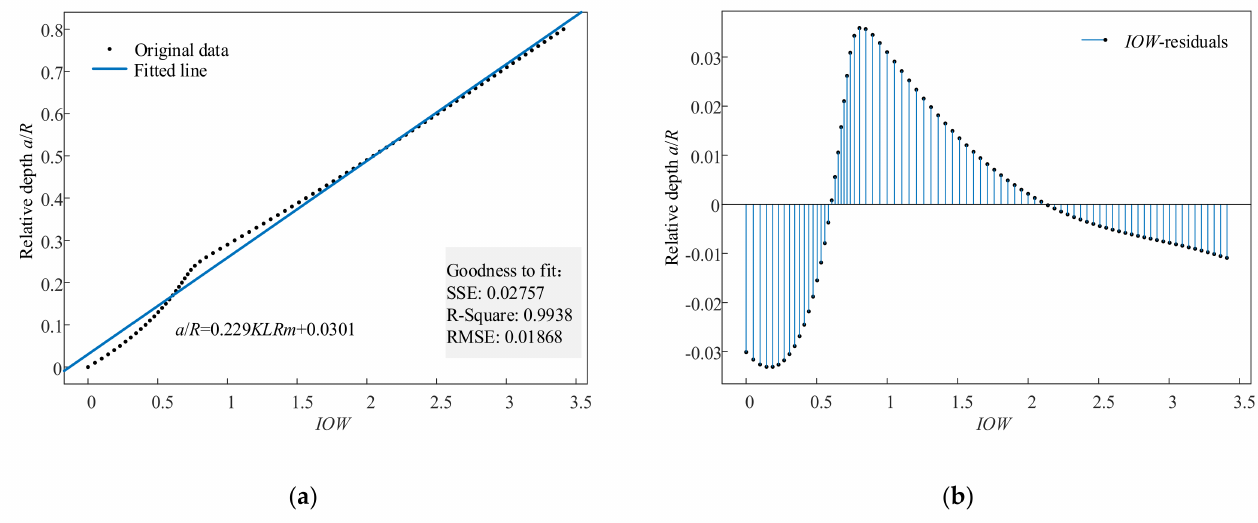
Figure 8. The fitting results of IOW : ( a ) fitted line and ( b ) residuals plot.